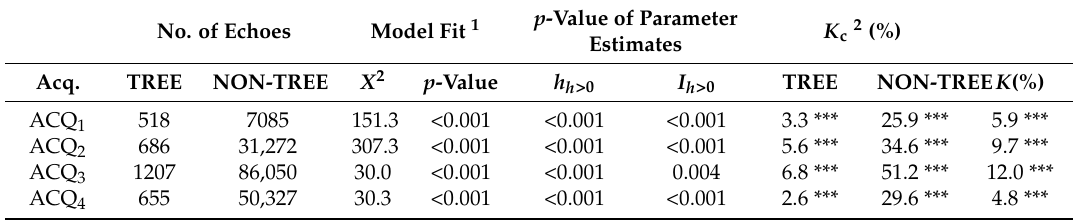
Table 9. Model fit, p -values of parameter estimates, and results of leave-one-out cross validation of logistic regression models fitted according to Equation (8). The models classify echoes of trees and non-tree objects based on range-normalized intensity and height of individual echoes with h > 0 for trees and sectors of the PCQ quadrants where non-tree echoes could be identified, see Figure